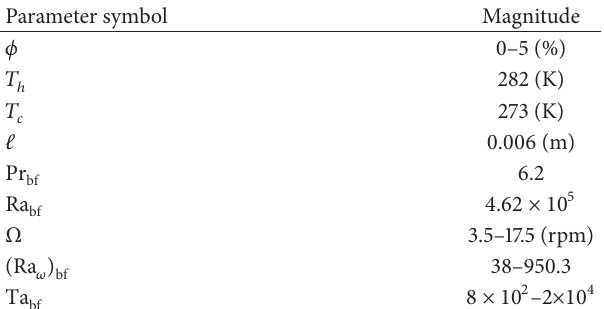
Figure 3: (a) Grid independency study: Nu versus number of grid points for 𝜙 = 0.05 and Ta process for present periodic oscillation problem. Table 2: Fixed variables and